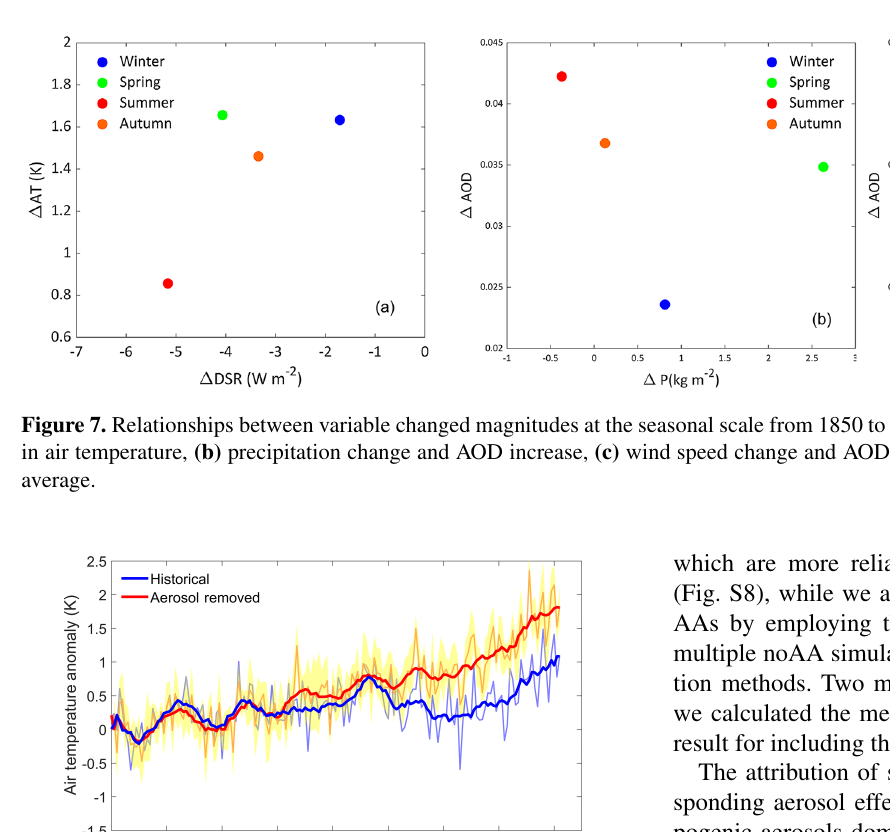
warming over the TP has been depressed by aerosols since 1850 in